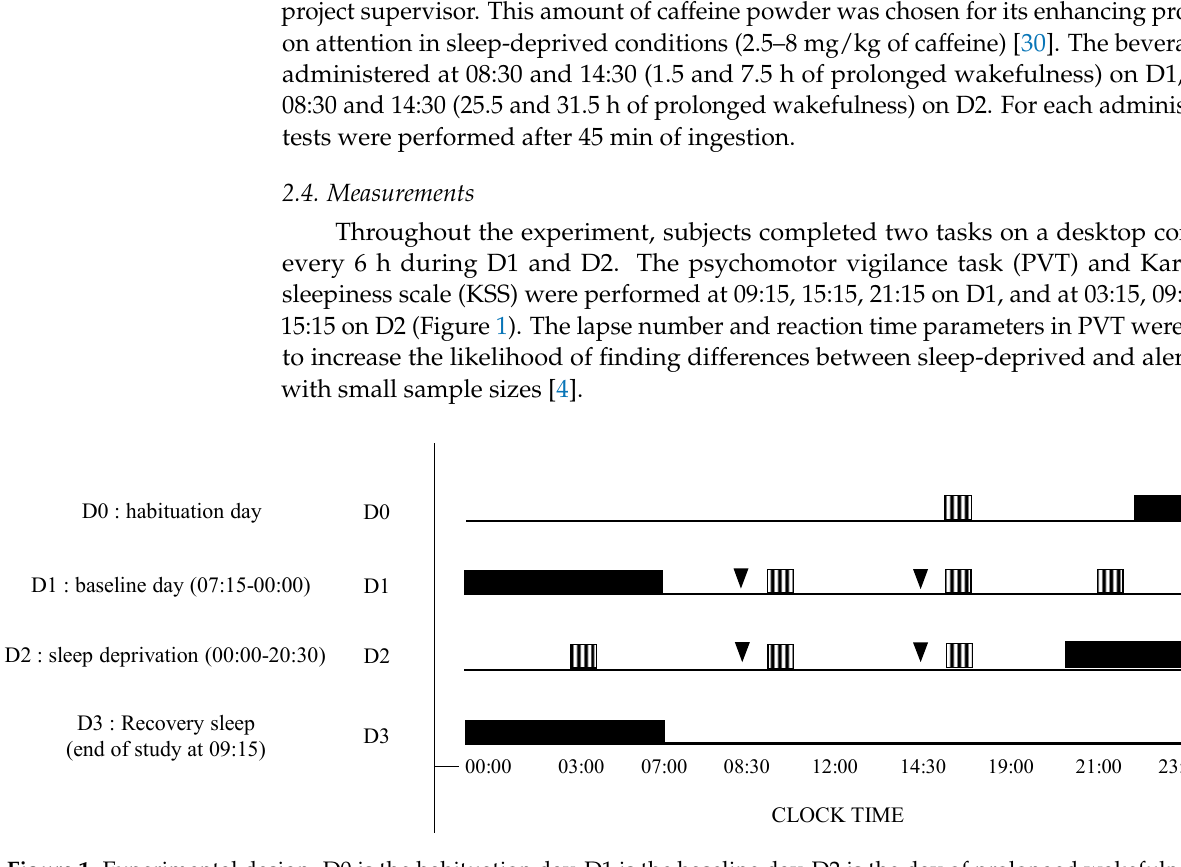
Figure 1. Experimental design. D0 is the habituation day, D1 is the baseline day, D2 is the day of prolonged wakefulness (i.e., sleep deprivation, between 00:00–20:30) and D3 is the recovery sleep and end of the study. Night sleep are the black bars, awaking periods black line, cognitive tests are the striped bars, and caffeine or placebo intake are the black arrows. Visual Analogic Scales (VAS), Karolinska Sleepiness Scale (KSS), and Psychomotor Vigilance Task (PVT) have been assessed at D1: 09:15, 15:15, 21:15 and D2: 03:15, 09:15, 15:15). VAS, KSS, PVT; Placebo or caffeine (2.5 mg/kg) treatment (at D1 and D2: 08:30, 14:30).